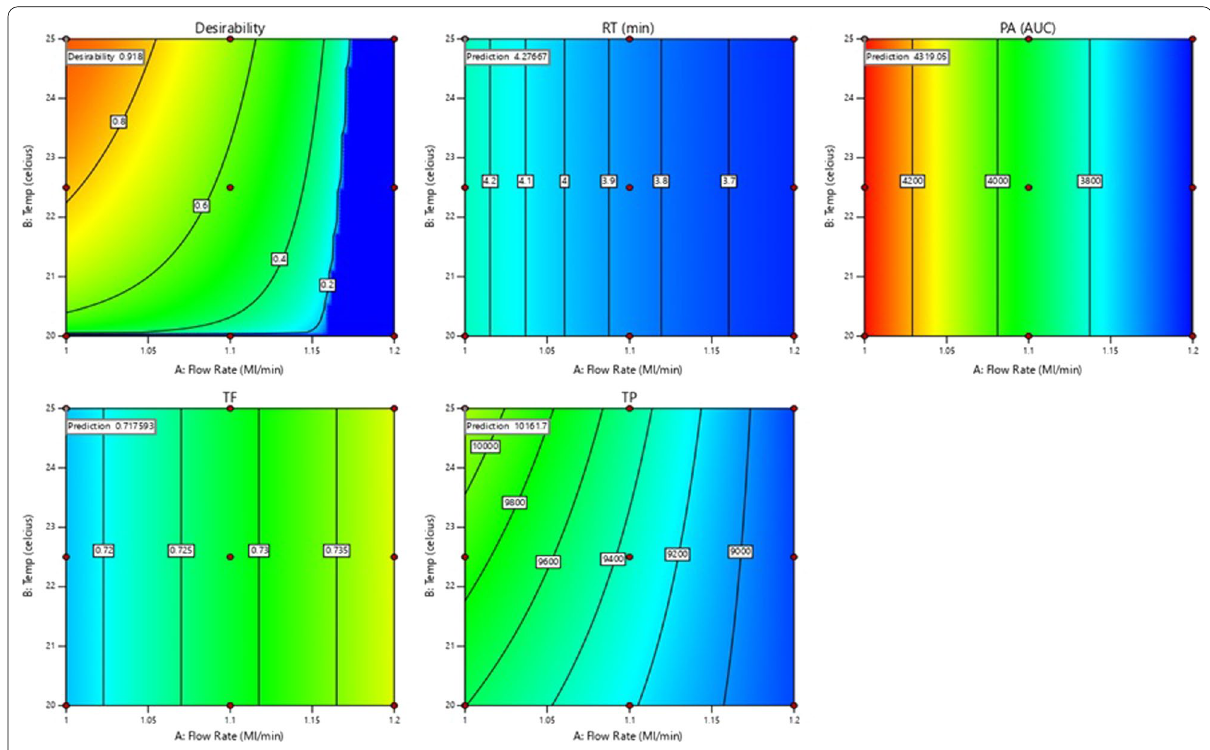
Fig. 11 Graphs showing numerical optimization with highest desirability